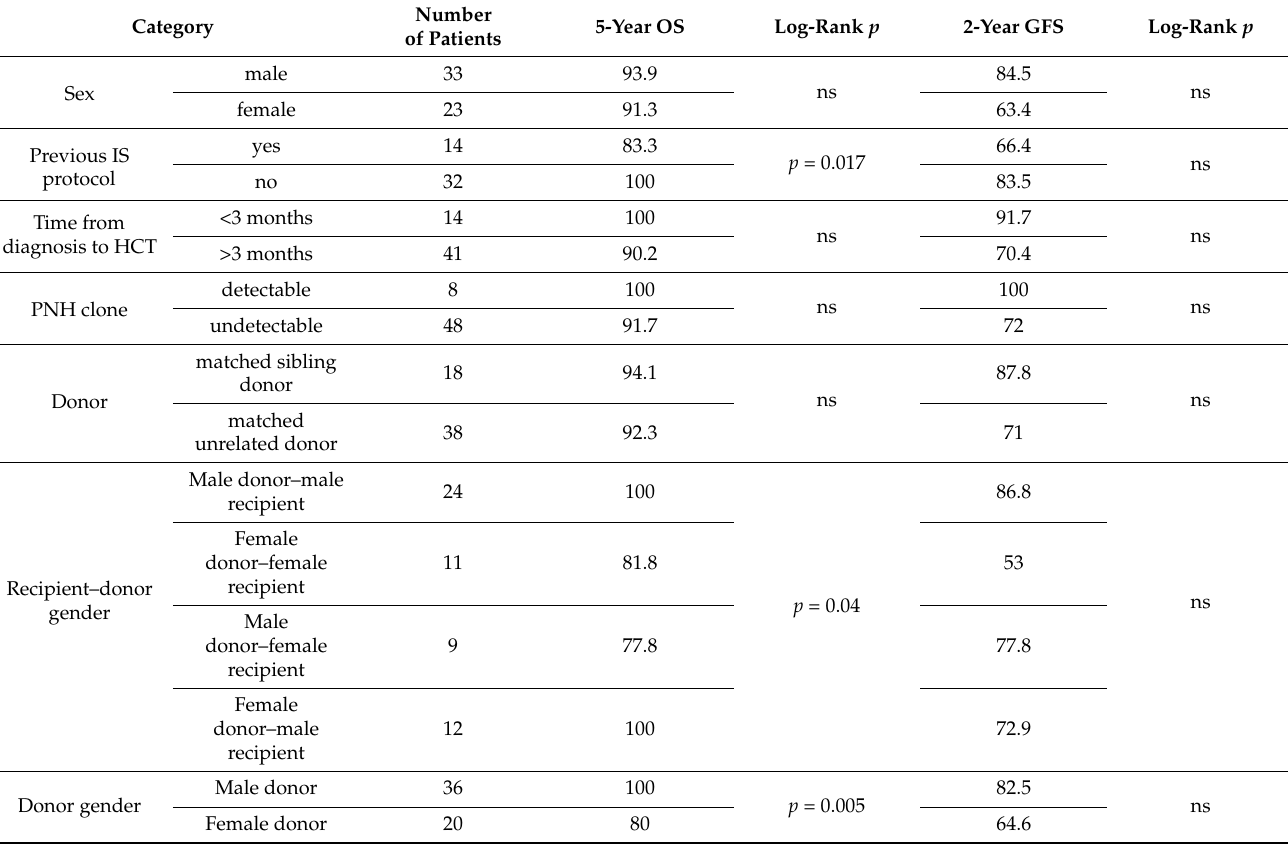
Table 2. Impact of factors affecting survival after